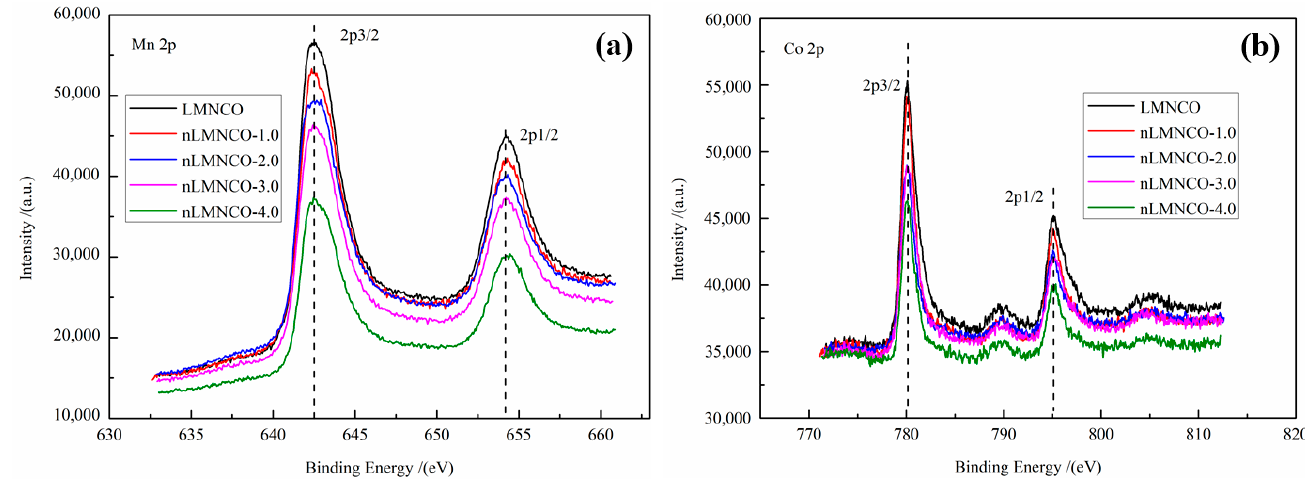
Figure 3. TEM images of the ( a ) LMNCO and ( b ) nLMNCO-3.0 samples.